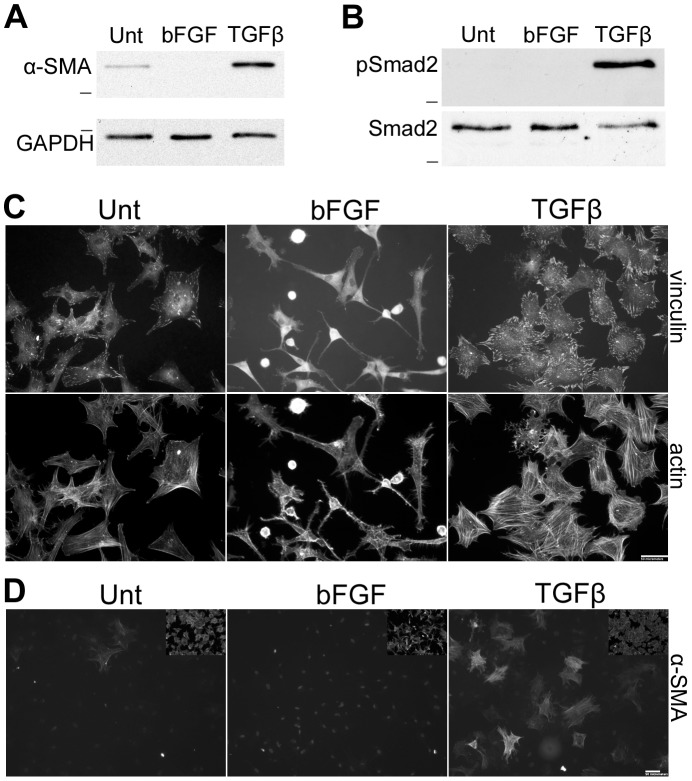
Cytoskeletal responses to TGF-β and bFGF.Cell lysates prepared from ADSCs treated with TGFβ, bFGF or untreated (Unt) were subjected to SDS-PAGE and immunoblotted. (A) 4-day lysates were probed with anti-α-SMA monoclonal antibody or anti-GAPDH antibody as a loading control. Blot is representative of three independent experiments. (B) Lysates prepared at 1 hour of treatment were immunoblotted with anti-phospho-Smad2 (pSmad2) and with total Smad antibody. Blot is representative of three independent experiments. Dash represents 37 kD (A) or 50 kD (B). (C, D) After 4 days of treatment, cells were replated onto collagen-coated glass coverslips for two hours before fixation, permeabilization, and staining with anti-vinculin antibody (C, top), rhodamine-phalloidin (C, bottom), or anti-α-SMA monoclonal antibody (D). Insets in (D) show rhodamine-phalloidin staining of the same fields. All images are representative of three independent experiments. Scale bars = 50 µm.